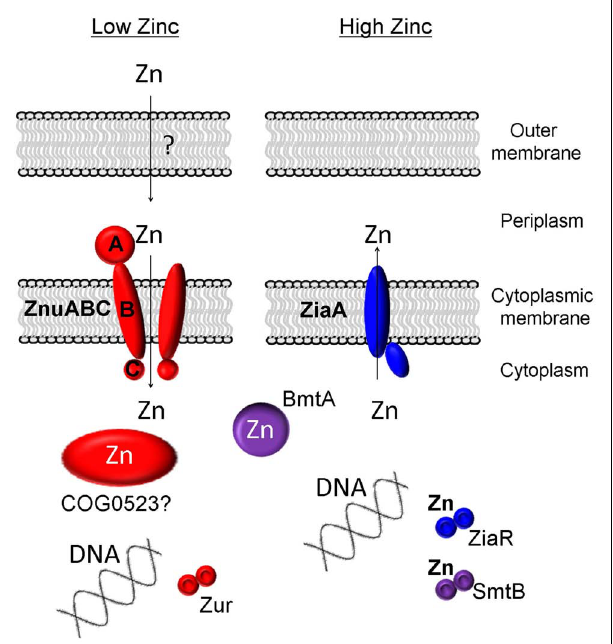
FIGURE 1 | Known and proposed elements of zinc homeostasis in cyanobacteria. A requirement for zinc is sensed by the transcriptional regulator Zur, leading to the upregulation of the components of the ZnuABC uptake system. Some members of the putative metallochaperone family COG0523 are also regulated by Zur, and have, in other bacteria, been shown to be expressed in response to zinc deficiency. In most freshwater cyanobacteria, excessive levels of zinc are sensed by SmtB and its homologs (ZiaR, AztR, BxmR), and these sensors regulate either the expression of efflux pumps (ZiaA) or metallothioneins (SmtA and